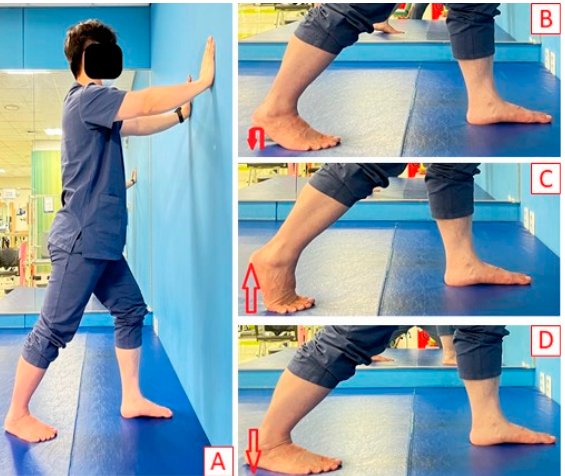
Figure 2. Stretching position. ( A ). Static stretching. ( B ). Ballistic stretching. ( C ). Dynamic stretching: raising the heel. ( D ). Dynamic stretching: lowering the